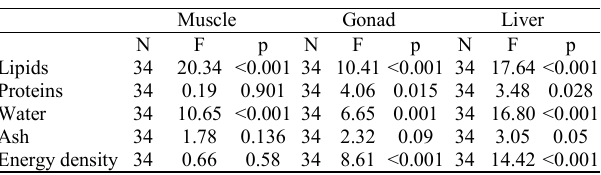
Table 2. ANOVA results performed to study seasonal changes of all biochemical components and energy density in each